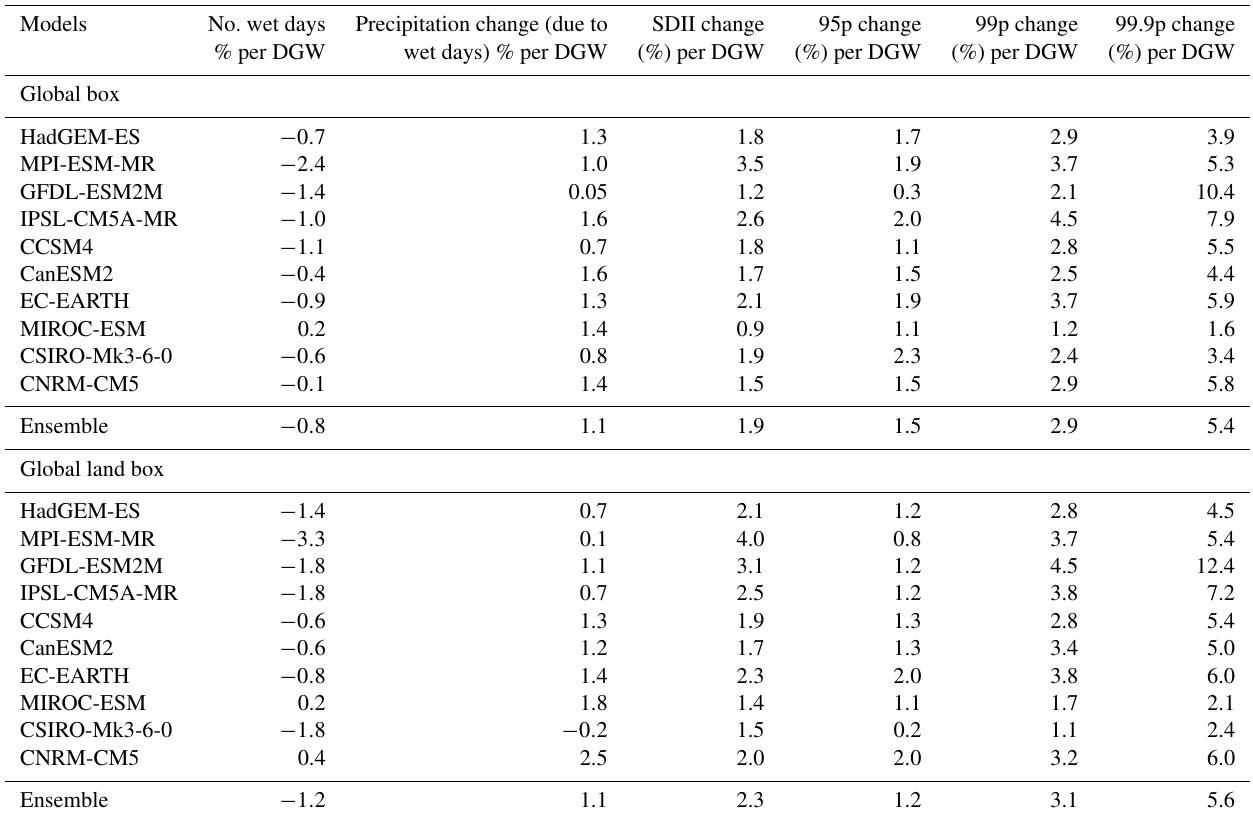
Table 1. Change in different daily precipitation indicators between 2071–2100 and 1976–2005 for the 10 CMIP5 GCMs of Giorgi et al. (2014a) expressed in % per degree of surface global warming over global (upper box) and global land (lower box) areas; “global” means the area between 60 ◦ S and 60 ◦ N. SDII is the precipitation intensity, 95p, 99p and 99.9p are the 95th, 99th and 99.9th percentiles, respectively, and the precipitation change only include wet days, i.e., days with precipitation greater than 1mmday − 1 .